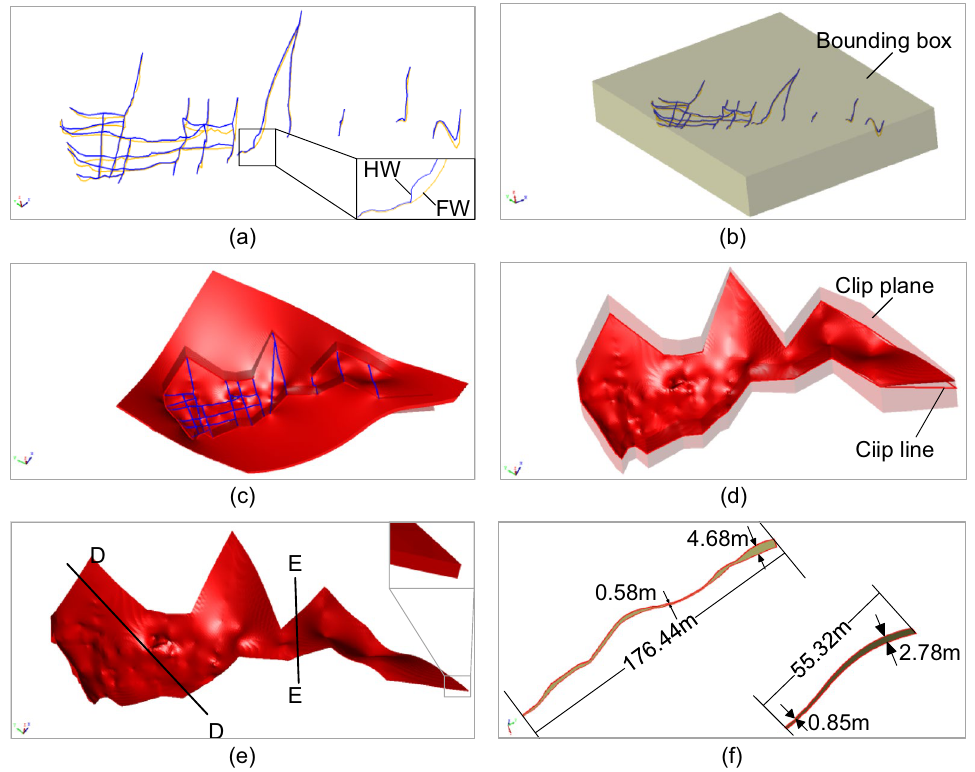
Figure 11. Implicit modeling of a narrow vein orebody model. ( a ) Contour polyline data; ( b ) rectangle bounding box; ( c ) initial model; ( d ) clipped model; ( e ) final model; ( f ) slicer view.